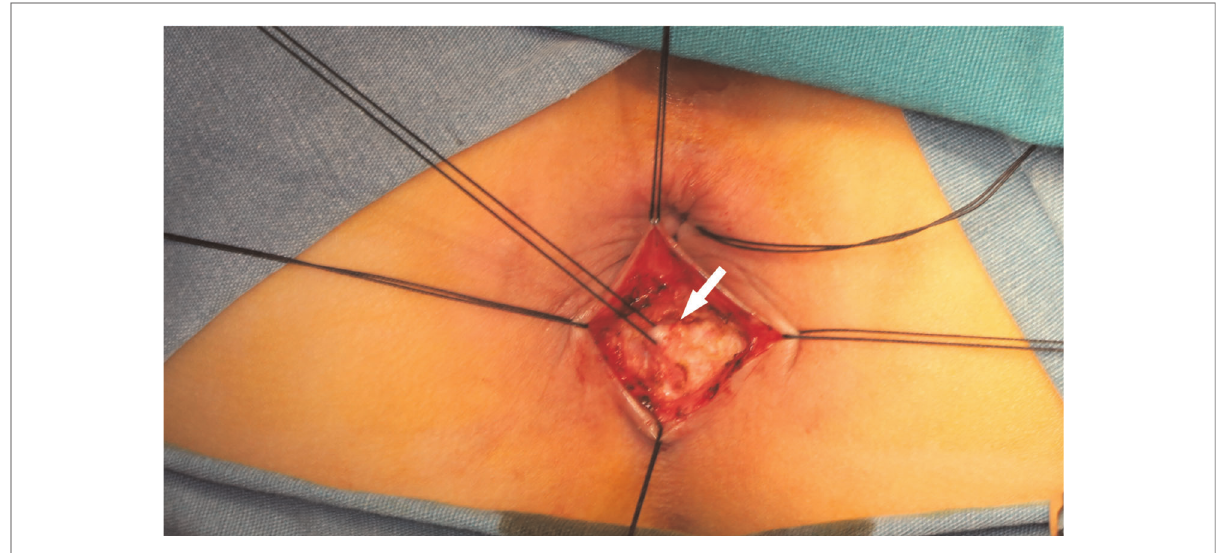
FIGURE 1 Intraoperative picture of internal sphincter myectomy. White arrow: internal anal